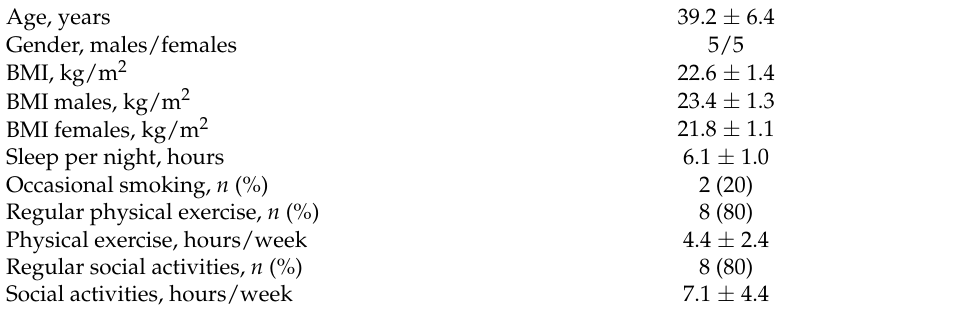
Table 2. Demographic and clinical features of the enrolled